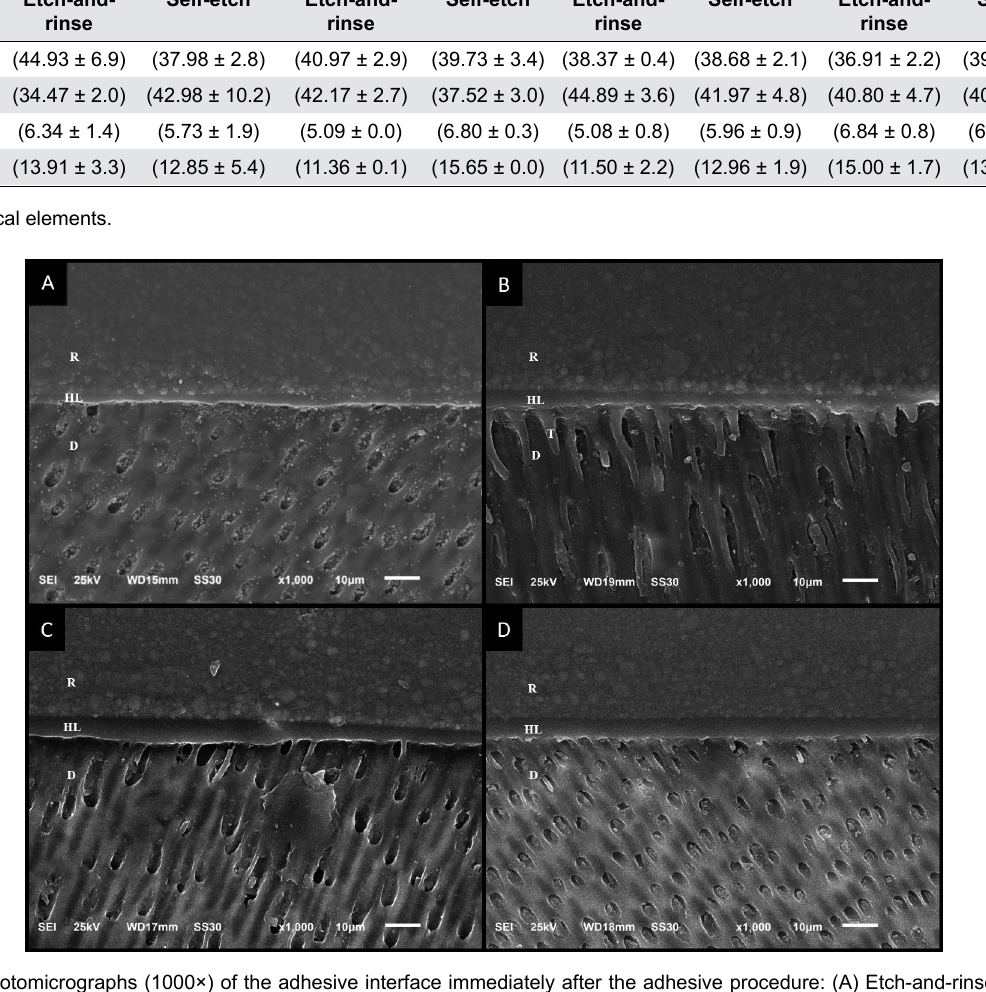
Figure 4- Photomicrographs (1000×) of the adhesive interface immediately after the adhesive procedure: (A) Etch-and-rinse adhesive; (B) Chitosan + Etch-and-rinse adhesive; (C) Self-etch adhesive (D) Chitosan + Self-etch adhesive. R, resin. HL, hybrid layer. D, dentin. T, resin